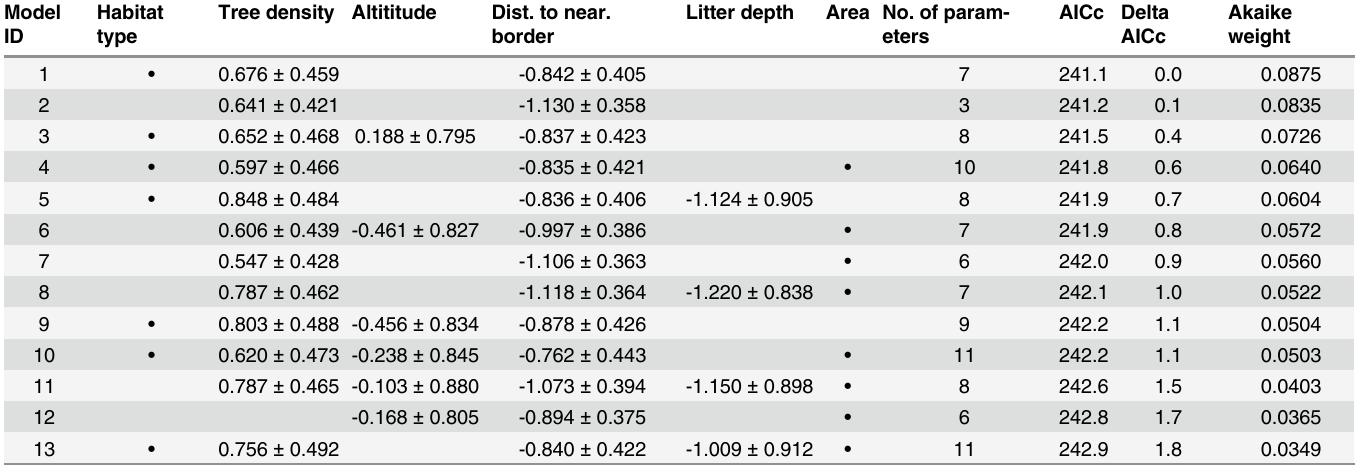
Table 3. Top 13 AICc models competing for first ranking model. Beta coefficients ± standard errors for each covariate are listed. The presence of cate- gorical variables Habitat type and Area in the models is indicated with the • symbol. Model ID